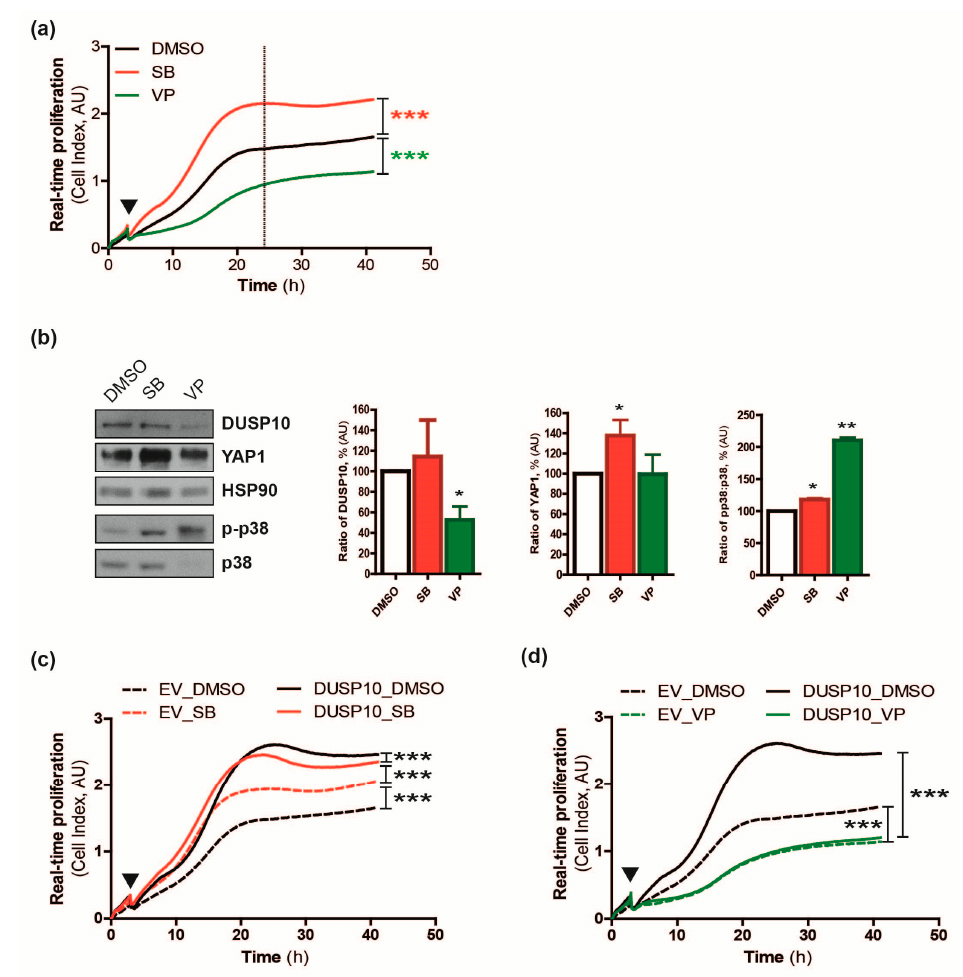
Figure 3. A YAP inhibitor prevents DUSP10-enhanced proliferation. ( a ) Growth curves of HT29 proliferative response to SB239063 (SB 1 µ M) and verteporfin (VP 1 µ M) for 40 h after 2 h seeding ( (cid:72) ) using real-time proliferation analysis by xCELLigence technology. Linear regression analysis was performed (*** p < 0.001). Representative graph of four independent experiments. ( b ) Expression of DUSP10, YAP1, p-p38, and p38 protein levels in HT29 treated with SB (1 µ M) and VP (1 µ M) for 24 h (dotted line within Figure 3a). (Left) A representative image of three independent experiments. (Right) Quantification of all blots performed (mean ± SEM; Student’s t -test; * p < 0.05, ** p < 0.01). ( c ) Growth curves of HT29-EV and HT29-DUSP10 proliferative response to SB 1 µ M and DMSO for 40 h after 2 h seeding ( (cid:72) ) using real-time proliferation analysis by xCELLigence technology. Linear regression analysis was performed (*** p < 0.001). Representative graph of three independent experiments. Completed immunoblots are in Figure S10. ( d ) Growth curves of HT29-EV and HT29-DUSP10 proliferative response treated with VP 1 µ M and DMSO for 40 h after 2 h seeding ( (cid:72) ) using real-time proliferation analysis by xCELLigence technology. Linear regression analysis was performed (*** p < 0.001). Representative graph of three independent